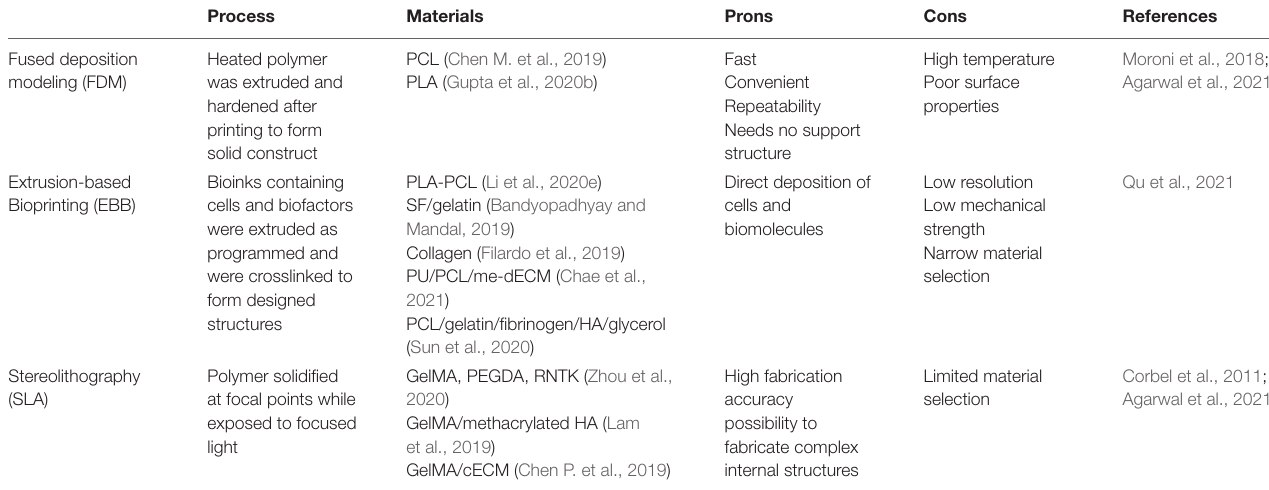
TABLE 5 | Traditional 3D printing techniques for meniscal tissue